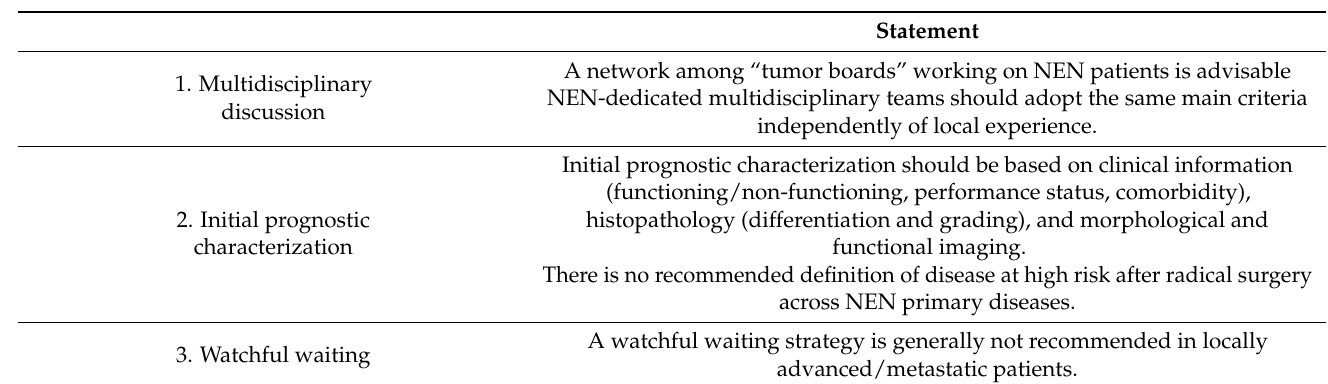
Table 1. Statements on diagnosis and management of